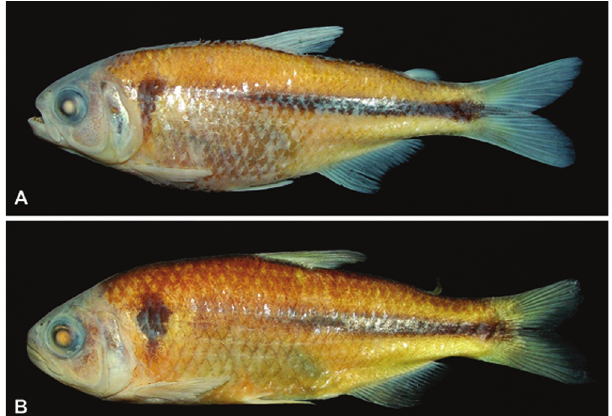
Fig. 1. Astyanax aff. scabripinnis . A - MZUEL 5656, 58,6mm CP, 1850 m a.s.l. B - MZUEL 5655, 83,5mm CP, 662 m a.s.l.